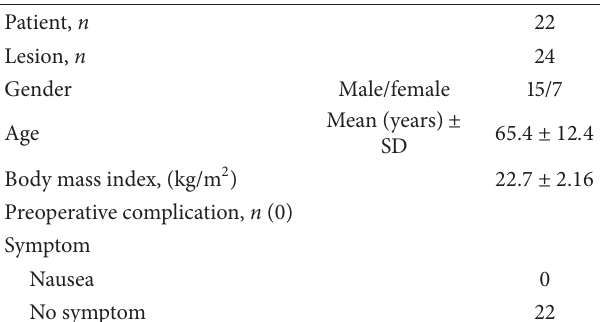
Table 1: Characteristics of the patients.